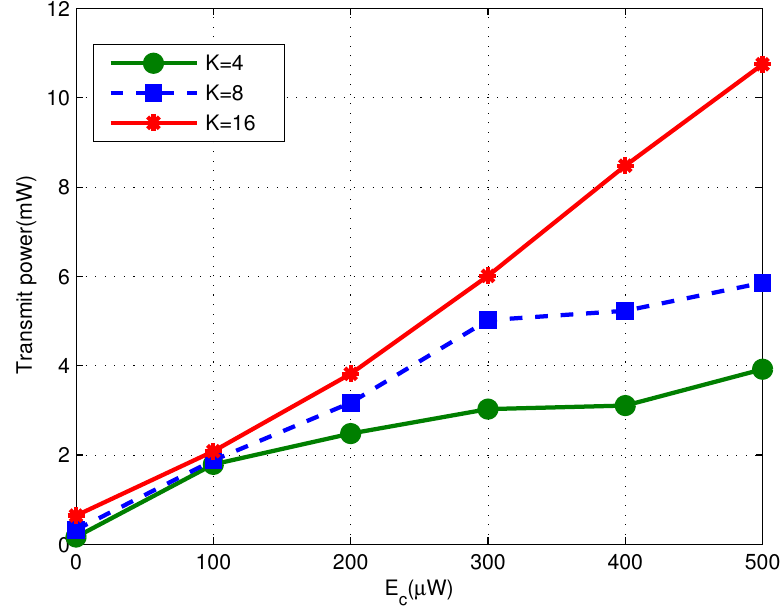
Figure 6. Transmit Power versus the harvest energy E c for the proposed algorithm ( σ 2 = − 112 dBm and K = 4 ,8